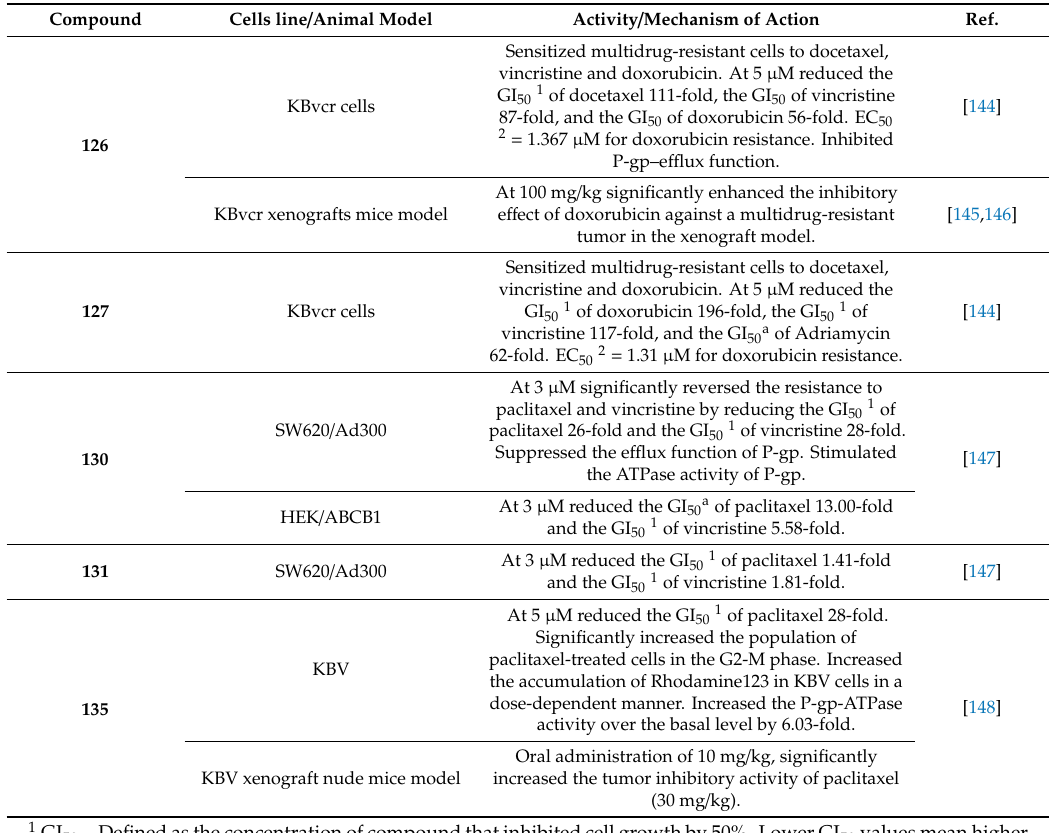
Figure 15. Triterpenoid nitrogen containing derivatives 125 – 136. Table 15. P-gp-resistance reversal properties of triterpene derivatives 126 , 127 , 130 , 131 , 135 .